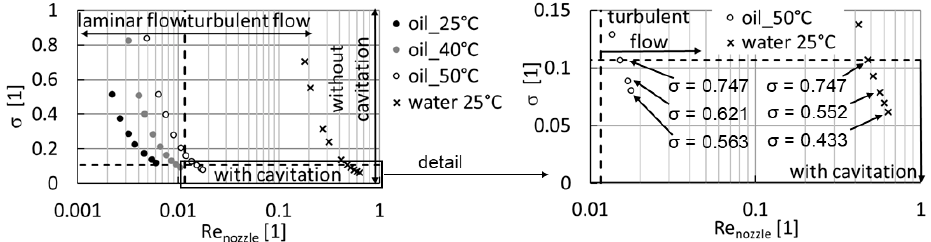
Figure 7. Dependence of cavitation number σ (1) vs. Reynolds number in the narrowest cross-section Re nozzle (1); detail of the cavitation area is to the right.